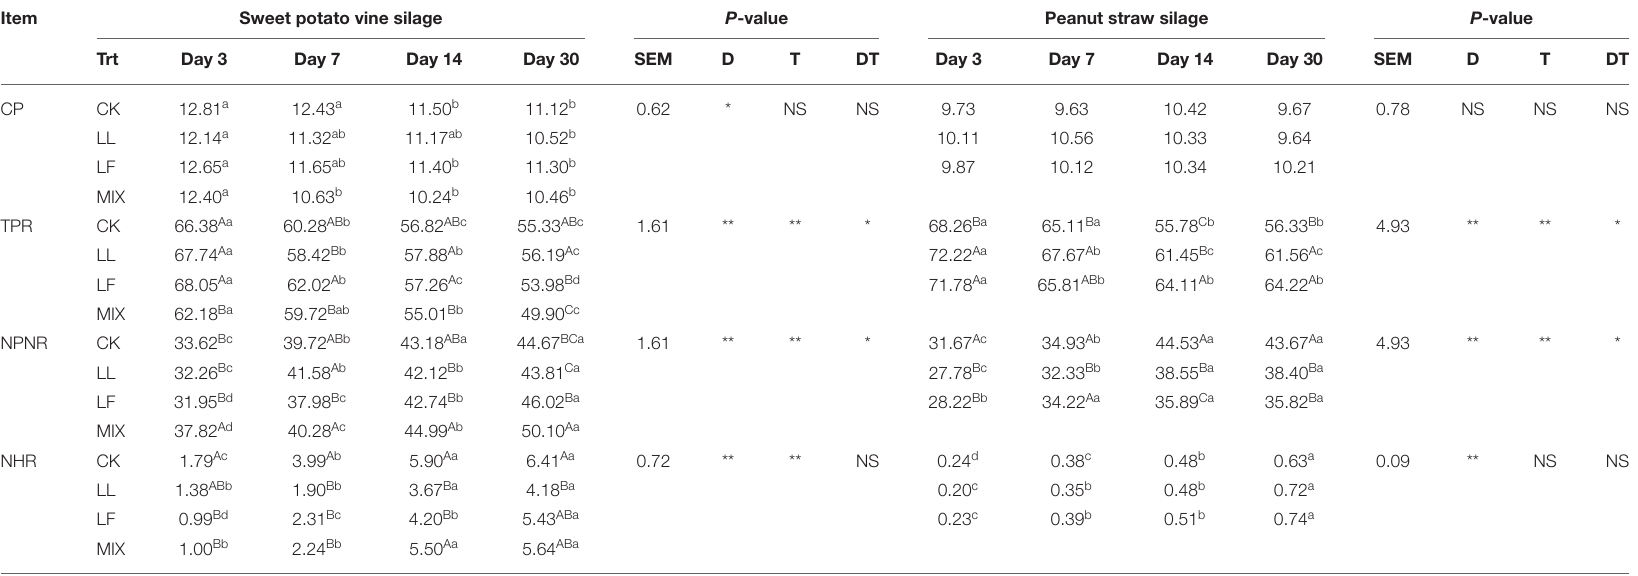
TABLE 3 | The effect of LAB inoculation on the nitrogen distribution in SPV and PS